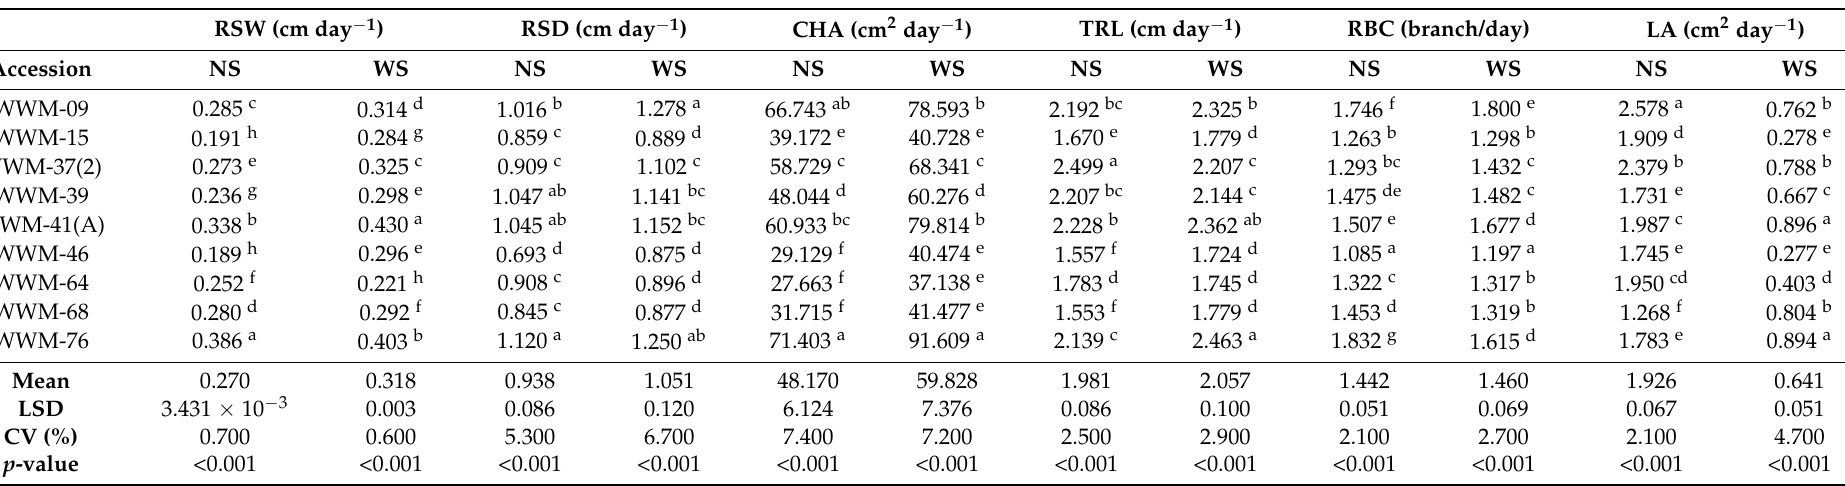
Table 1. Average daily growth rates of root traits and leaf area measured in nine citron watermelon accessions from 8 to 35 DAP under non-stress and water-stress